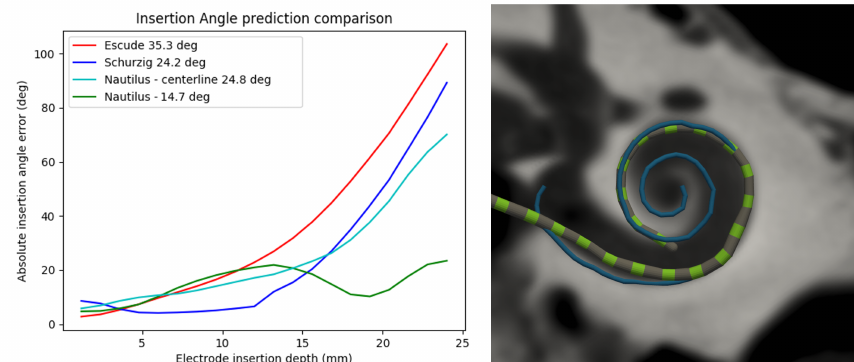
Figure 4. Angular insertion depth estimation based on the number of electrodes inserted inside the cochlea. The comparison graph shows ( left ), contrarily to our approach, how the performance of state-of-the-art approaches decreases exponentially with insertion depth. On the ( right ) is an example of a predicted trajectory (blue) and inserted